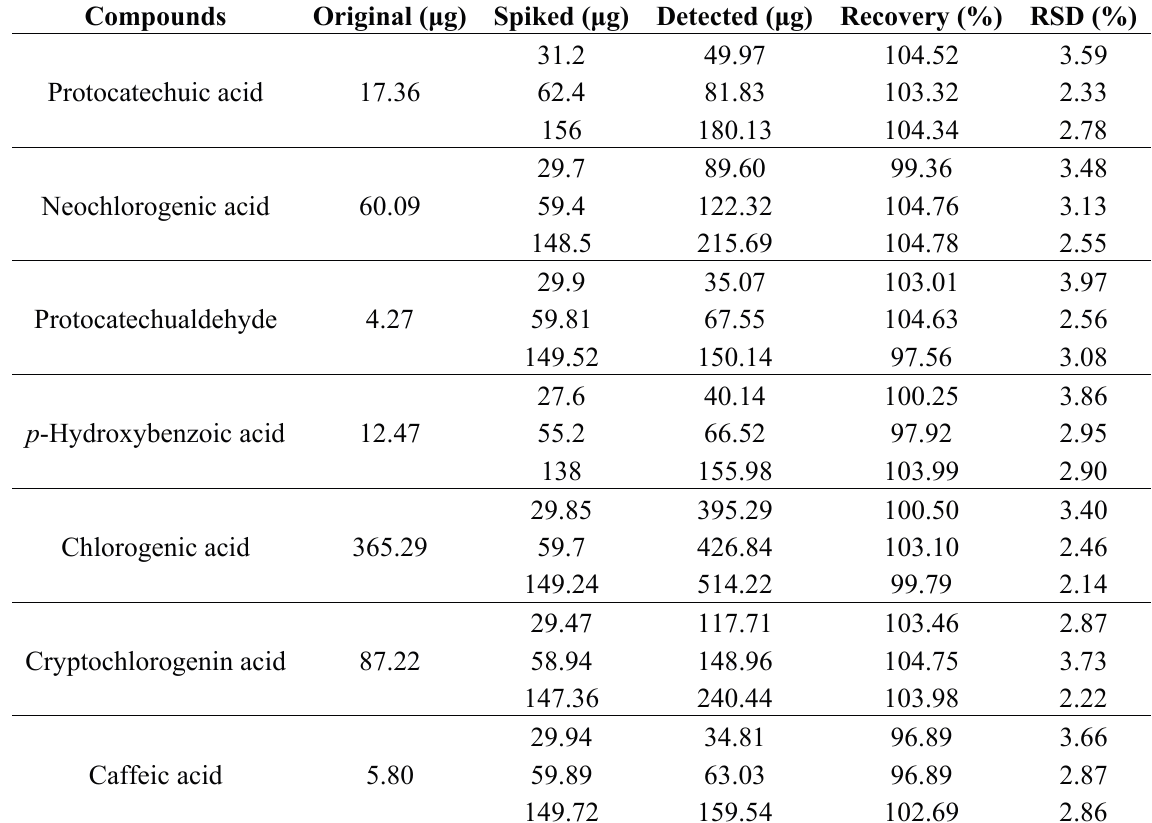
Table 3. Recovery data of the proposed method ( n =